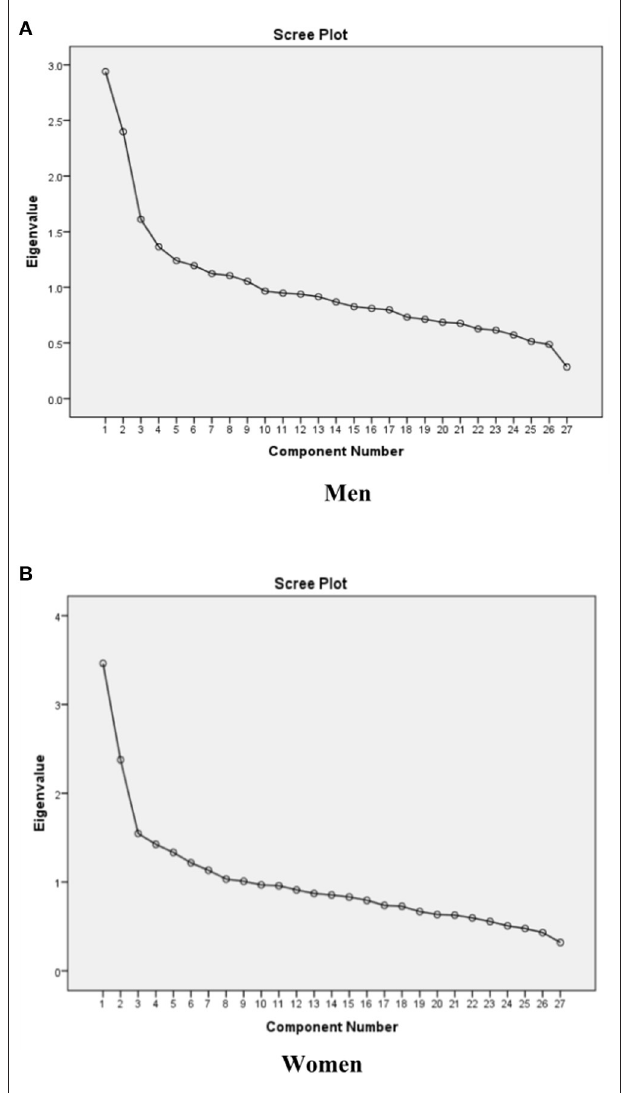
FIGURE 1 | Scree plots of the eigenvalues to determine the appropriate number of dietary patterns among (A) men, (B) women.